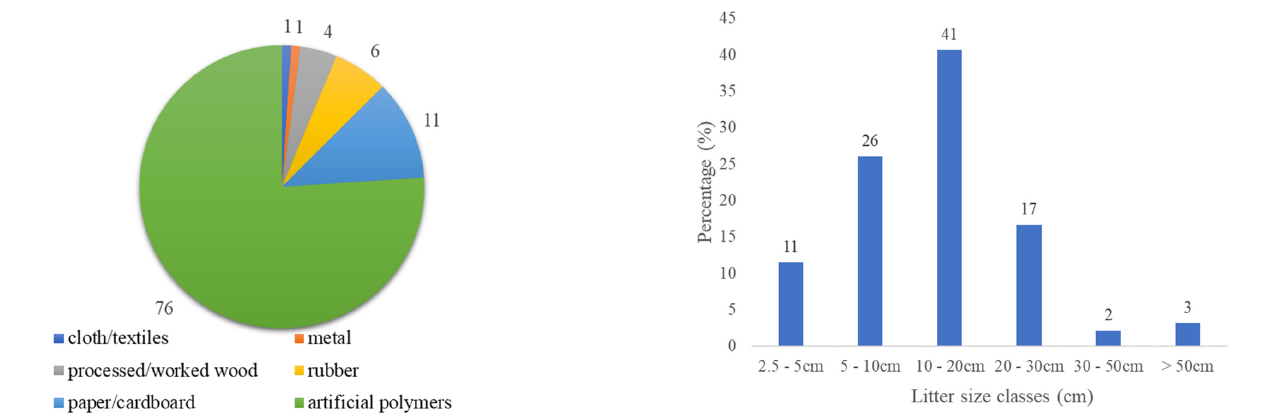
Figure 8. Percentage of materials of litter > 2.5 cm ( left ) and litter size classes ( right ) recorded at the Matsesta River.